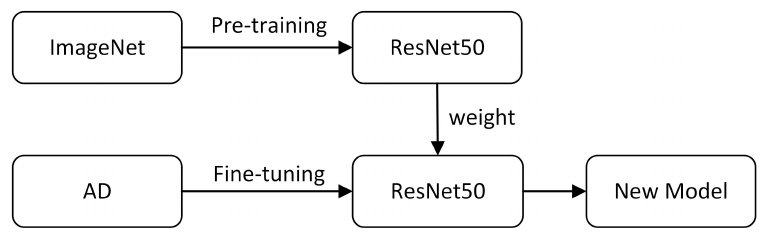
Figure 1. Transfer